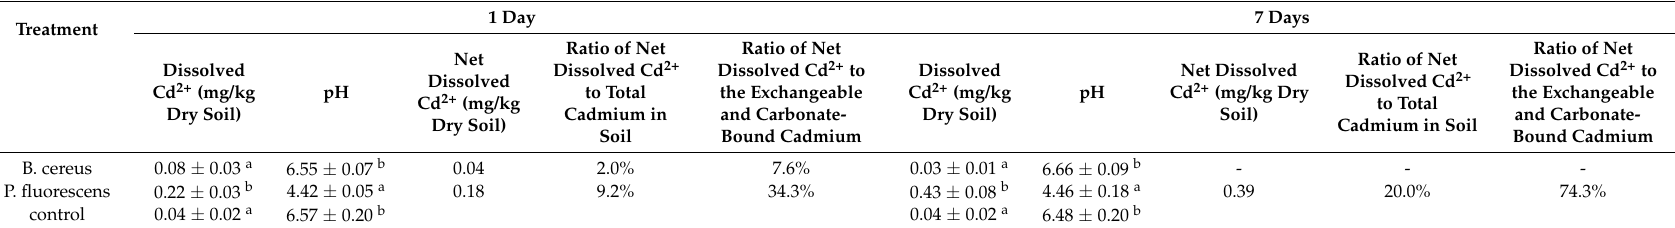
Table 2. Effect of B. cereus and P. fluorescens on cadmium mobility in Cd-polluted soil.